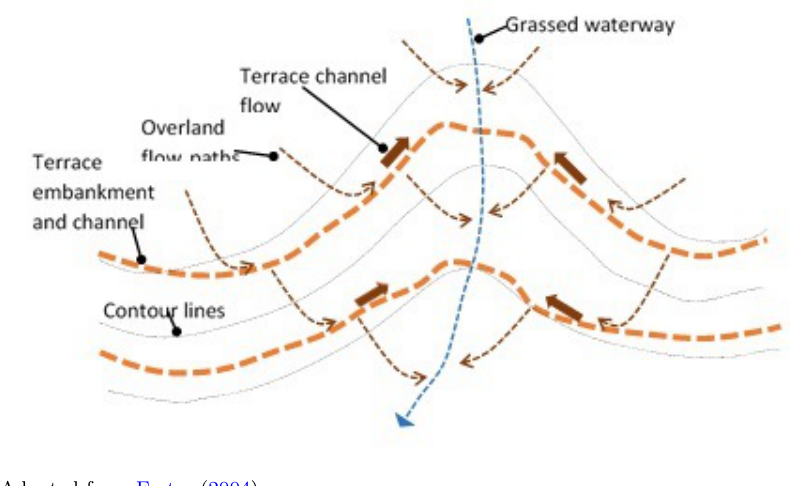
Figure 8: Scheme of the overland flows in a slope with terraced